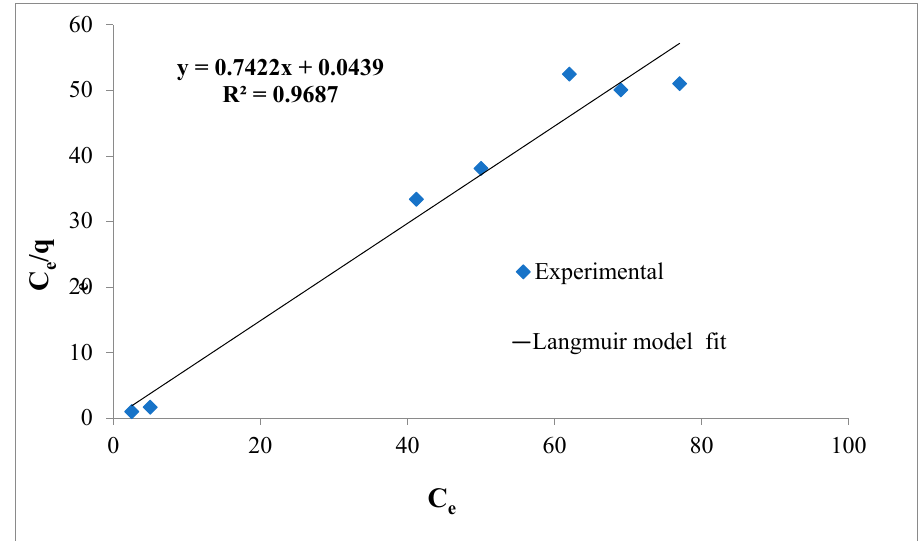
Figure 10. Langmuir adsorption isotherm model for 2,4-D on TMS.